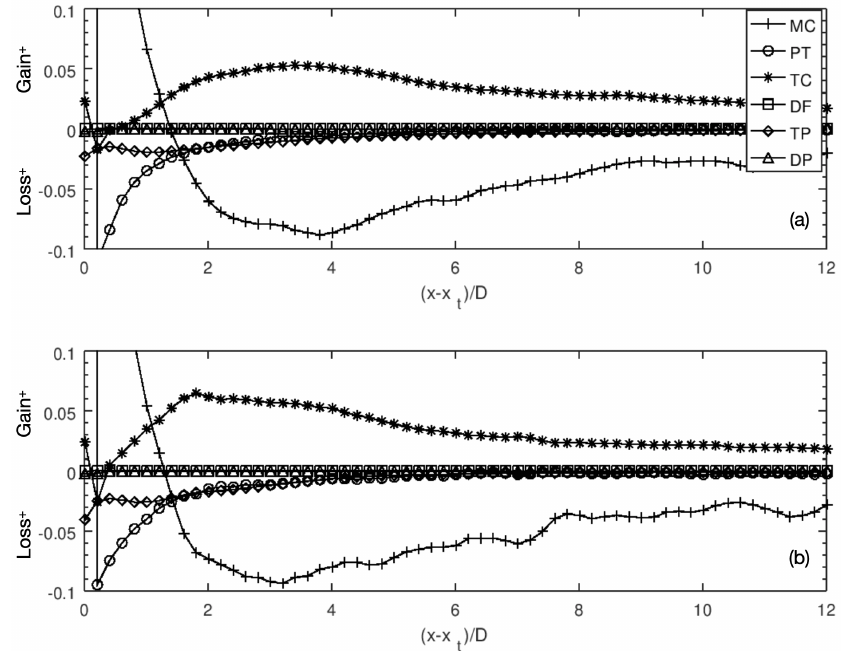
Figure 10. Budget of mean kinetic energy for ( a ) T80 and ( b ) T27, respectively. Line with crosses: MC term (Equation (6)); Line with circles: PT term (Equation (7)); Line with stars: TC term (Equation (8)); Line with squares: DF term (Equation (9)); Line with diamonds: TP term (Equation (10)); Line with triangles: DP term (Equation (11)). Different terms are normalized using 1